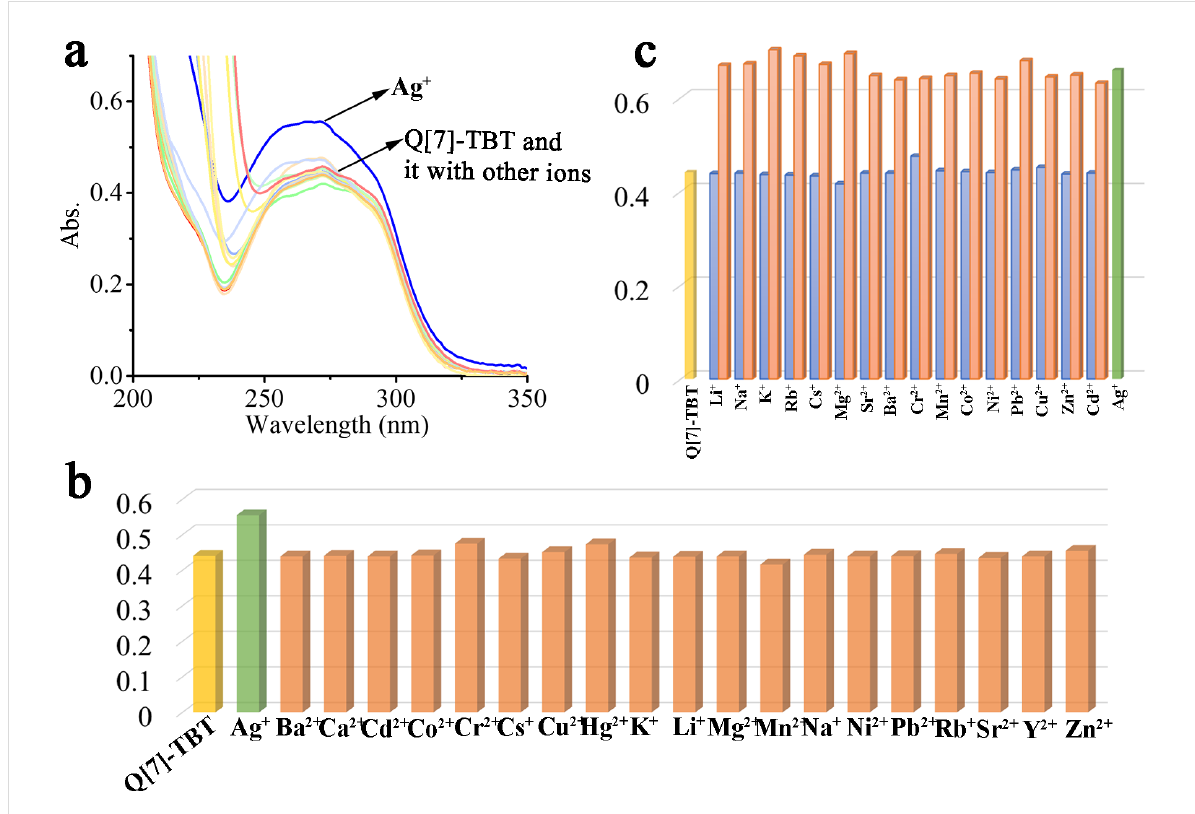
Figure 5: The UV–vis spectra (a) of Q[7]-TBT (3:1, 20 μ M) affected by M n + (50 equivalents); histogram of (b) Q[7]-TBT in the presence of M n + and (c) the anti-interference experiment.